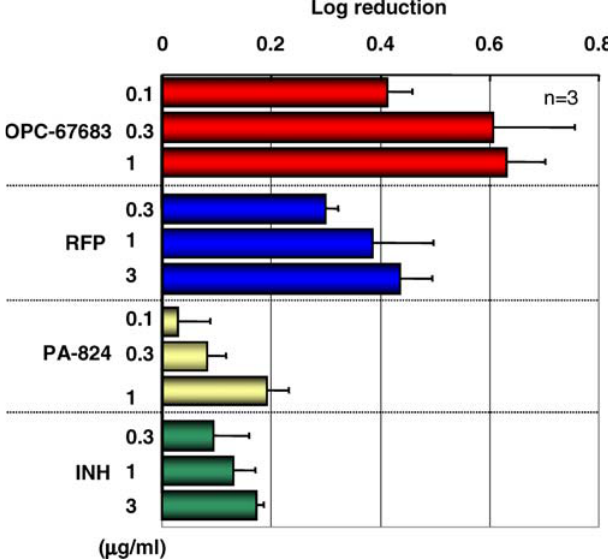
Figure 3. Effect of Pulsed Exposures to OPC-67683, RFP, INH, and PA-824 on the Intracellular Growth of M. tuberculosis H37Rv within THP-1 Cells Infected cells were incubated with the test compound for 4 h, washed, cultured until 68 h at 37 8 C, plated on 7H11 agar, and counted for colonies after 16 d of growth at 37 8 C. Values represent mean 6 S.D ( n ¼ 3).